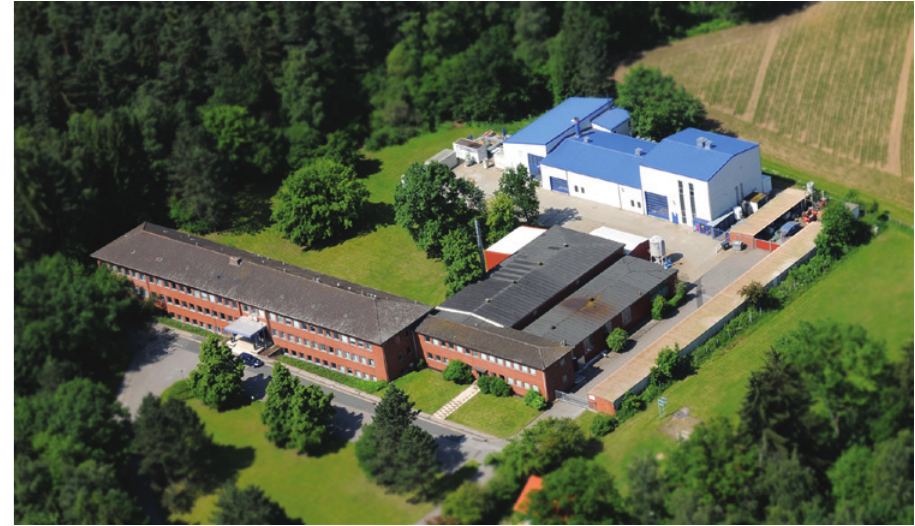
Figure 2: Institute’s complex in Sulzbach-Rosenberg. © Fraunhofer UMSICHT.